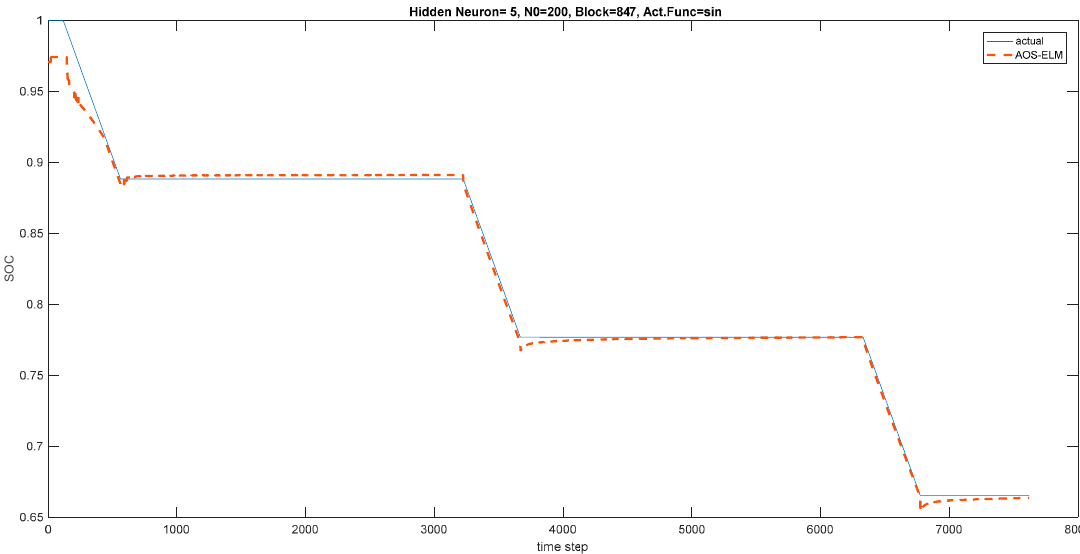
Figure 22. Training time and testing RMSE for a 12-cell battery at 25 °C for five neurons (N0 = 200, block range = 847, sinusoidal activation function).